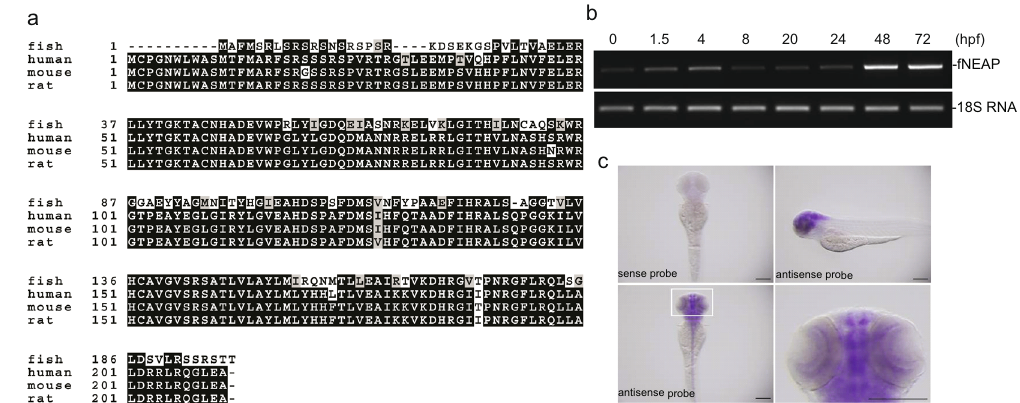
Figure 5. Zebrafish NEAP is expressed in central nerve system. ( a ) Alignment of zebrafish (fish), human, mouse, and rat NEAP protein sequences was performed using the Clustal Omega and BoxShade programs. ( b ) Expression levels of NEAP and 18S ribosomal RNA (18S RNA) in zebrafish embryos collected at the indicated time points were determined using the RT-PCR method. ( c ) Expression pattern of zebrafish NEAP (shown in purple color) was determined using the in situ hybridization assay as described in the Methods. The inset of the lower left panel was enlarged in the lower right panel to show the positive hybridization signals in the eyes. Scale bar: 0.2